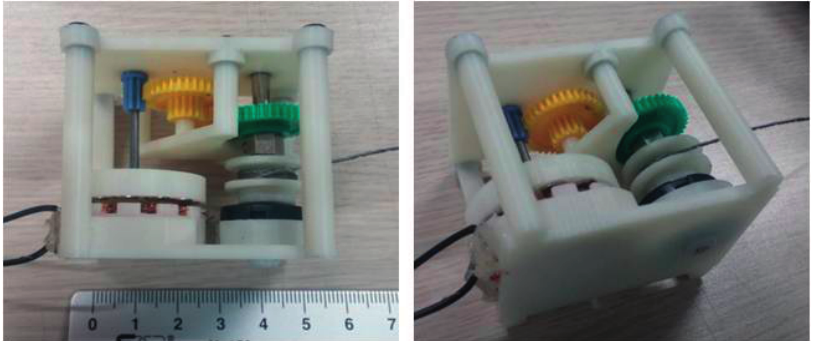
Figure 5. Prototype of the developed pulling energy harvester.